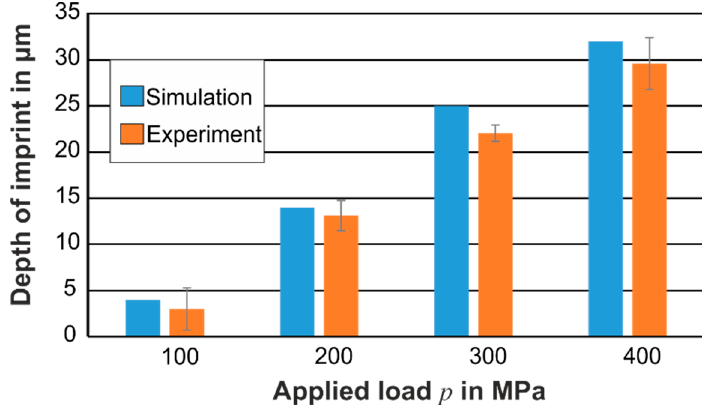
Figure 10. Depth of imprints in AA5182 surface caused by twill woven (280 g/m 2 ) fabrics—comparison between simulation and experiments.